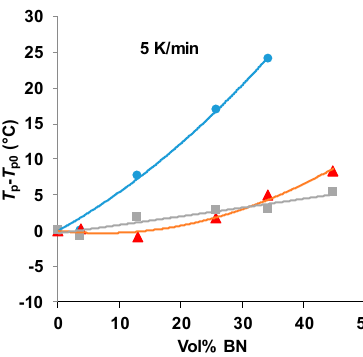
Figure 7. Peak temperature during non-isothermal cure of the epoxy-thiol system relative to that for the unfilled system, T p − T p0 , as a function of BN content for the heating rate of 5 K/min. Effect of platelet size: 2 µm, blue circles; 30 µm, red triangles; 180 µm, grey squares.